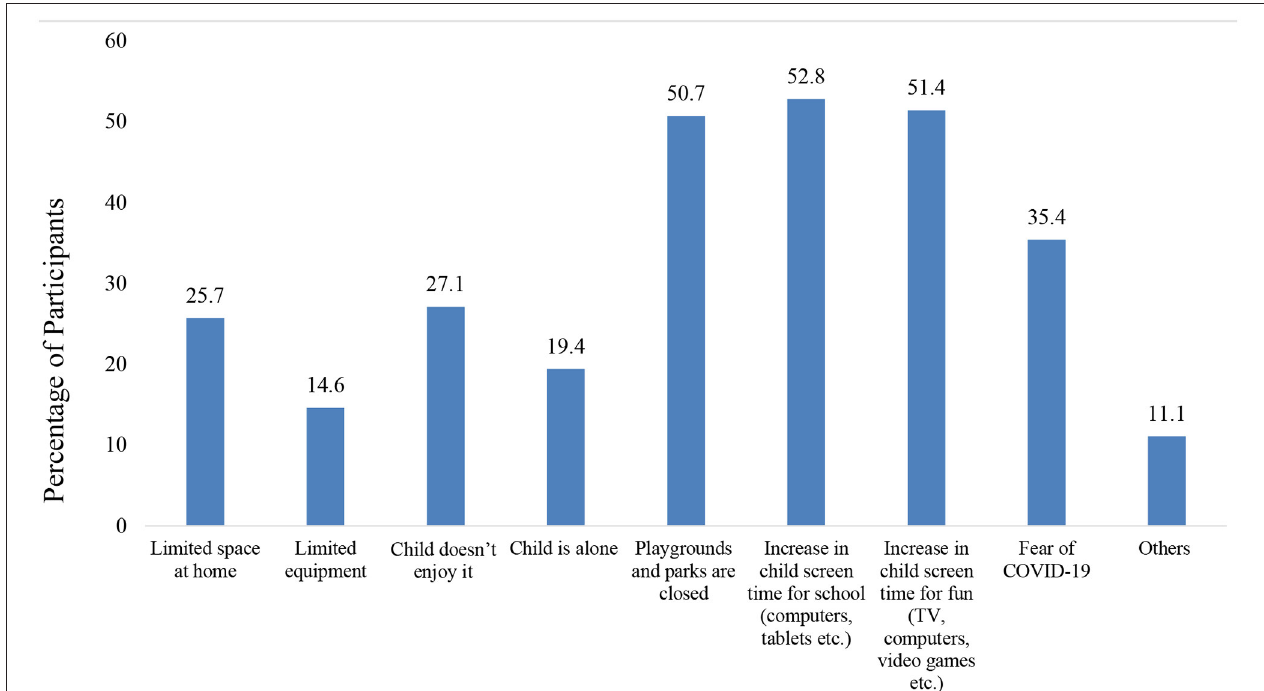
FIGURE 1 | Factors that decreased the child’s physical activity during quarantine.